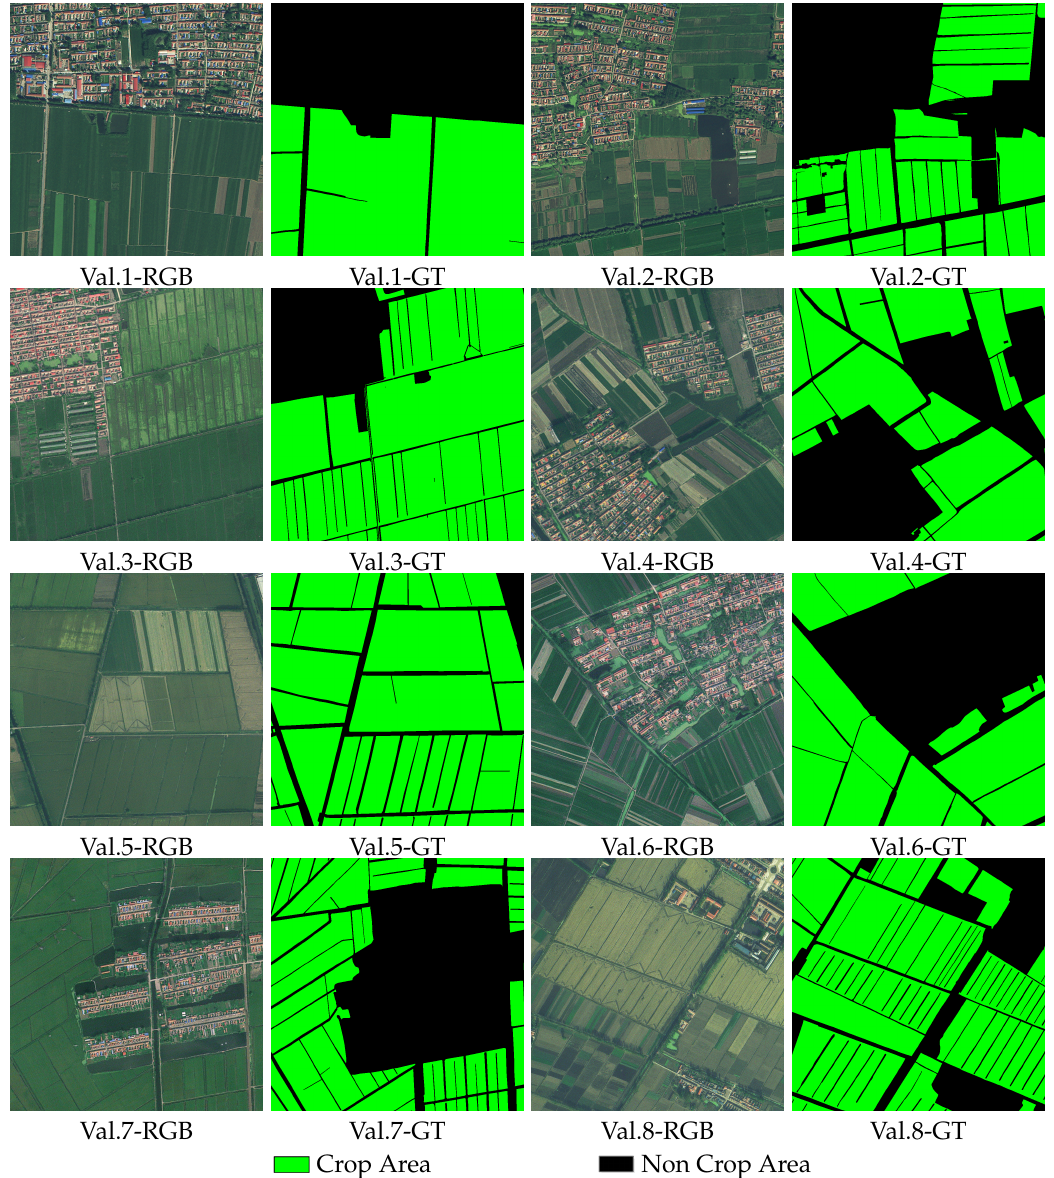
Figure 4. The eight validation (Val) slices with red-greed-blue (RGB) bands and their ground truth (GT) labels.